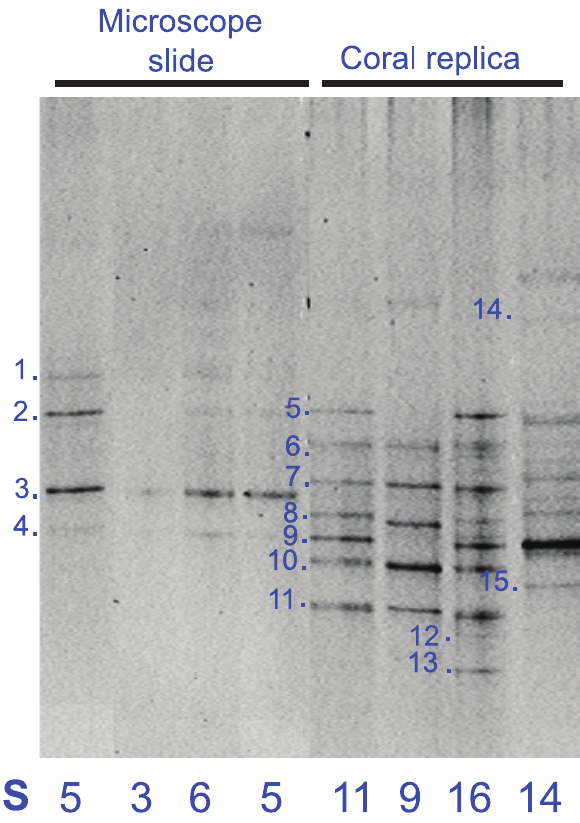
Figure 1. Composite DGGE image showing replicates collected at 4 h of biofilm development on microscopic slides and replica coral nubbins with dominant bands sequenced (Table 2), gel-to-gel comparisons were standardised using internally run marker lanes and analysed using BioNumerics software. S= number of bands visible in DGGE using BioNumerics representing relative diversity.